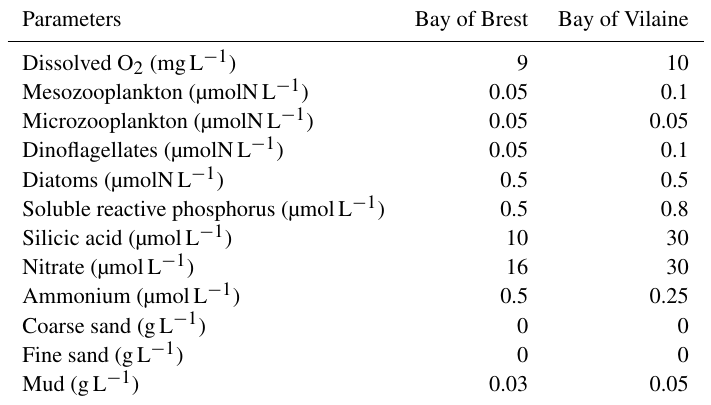
Table 1. Initial conditions in the water column for the MARS-1DV model for the beginning of the simulation on the 15 February.